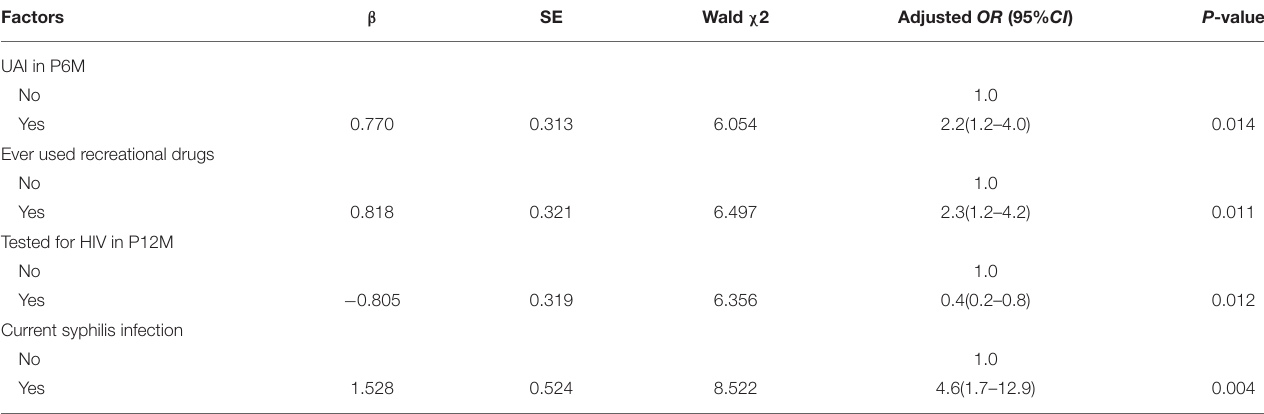
TABLE 4 | Factors associated with HIV infection by multivariate logistic regression analysis among SMSM in Nanjing, China.